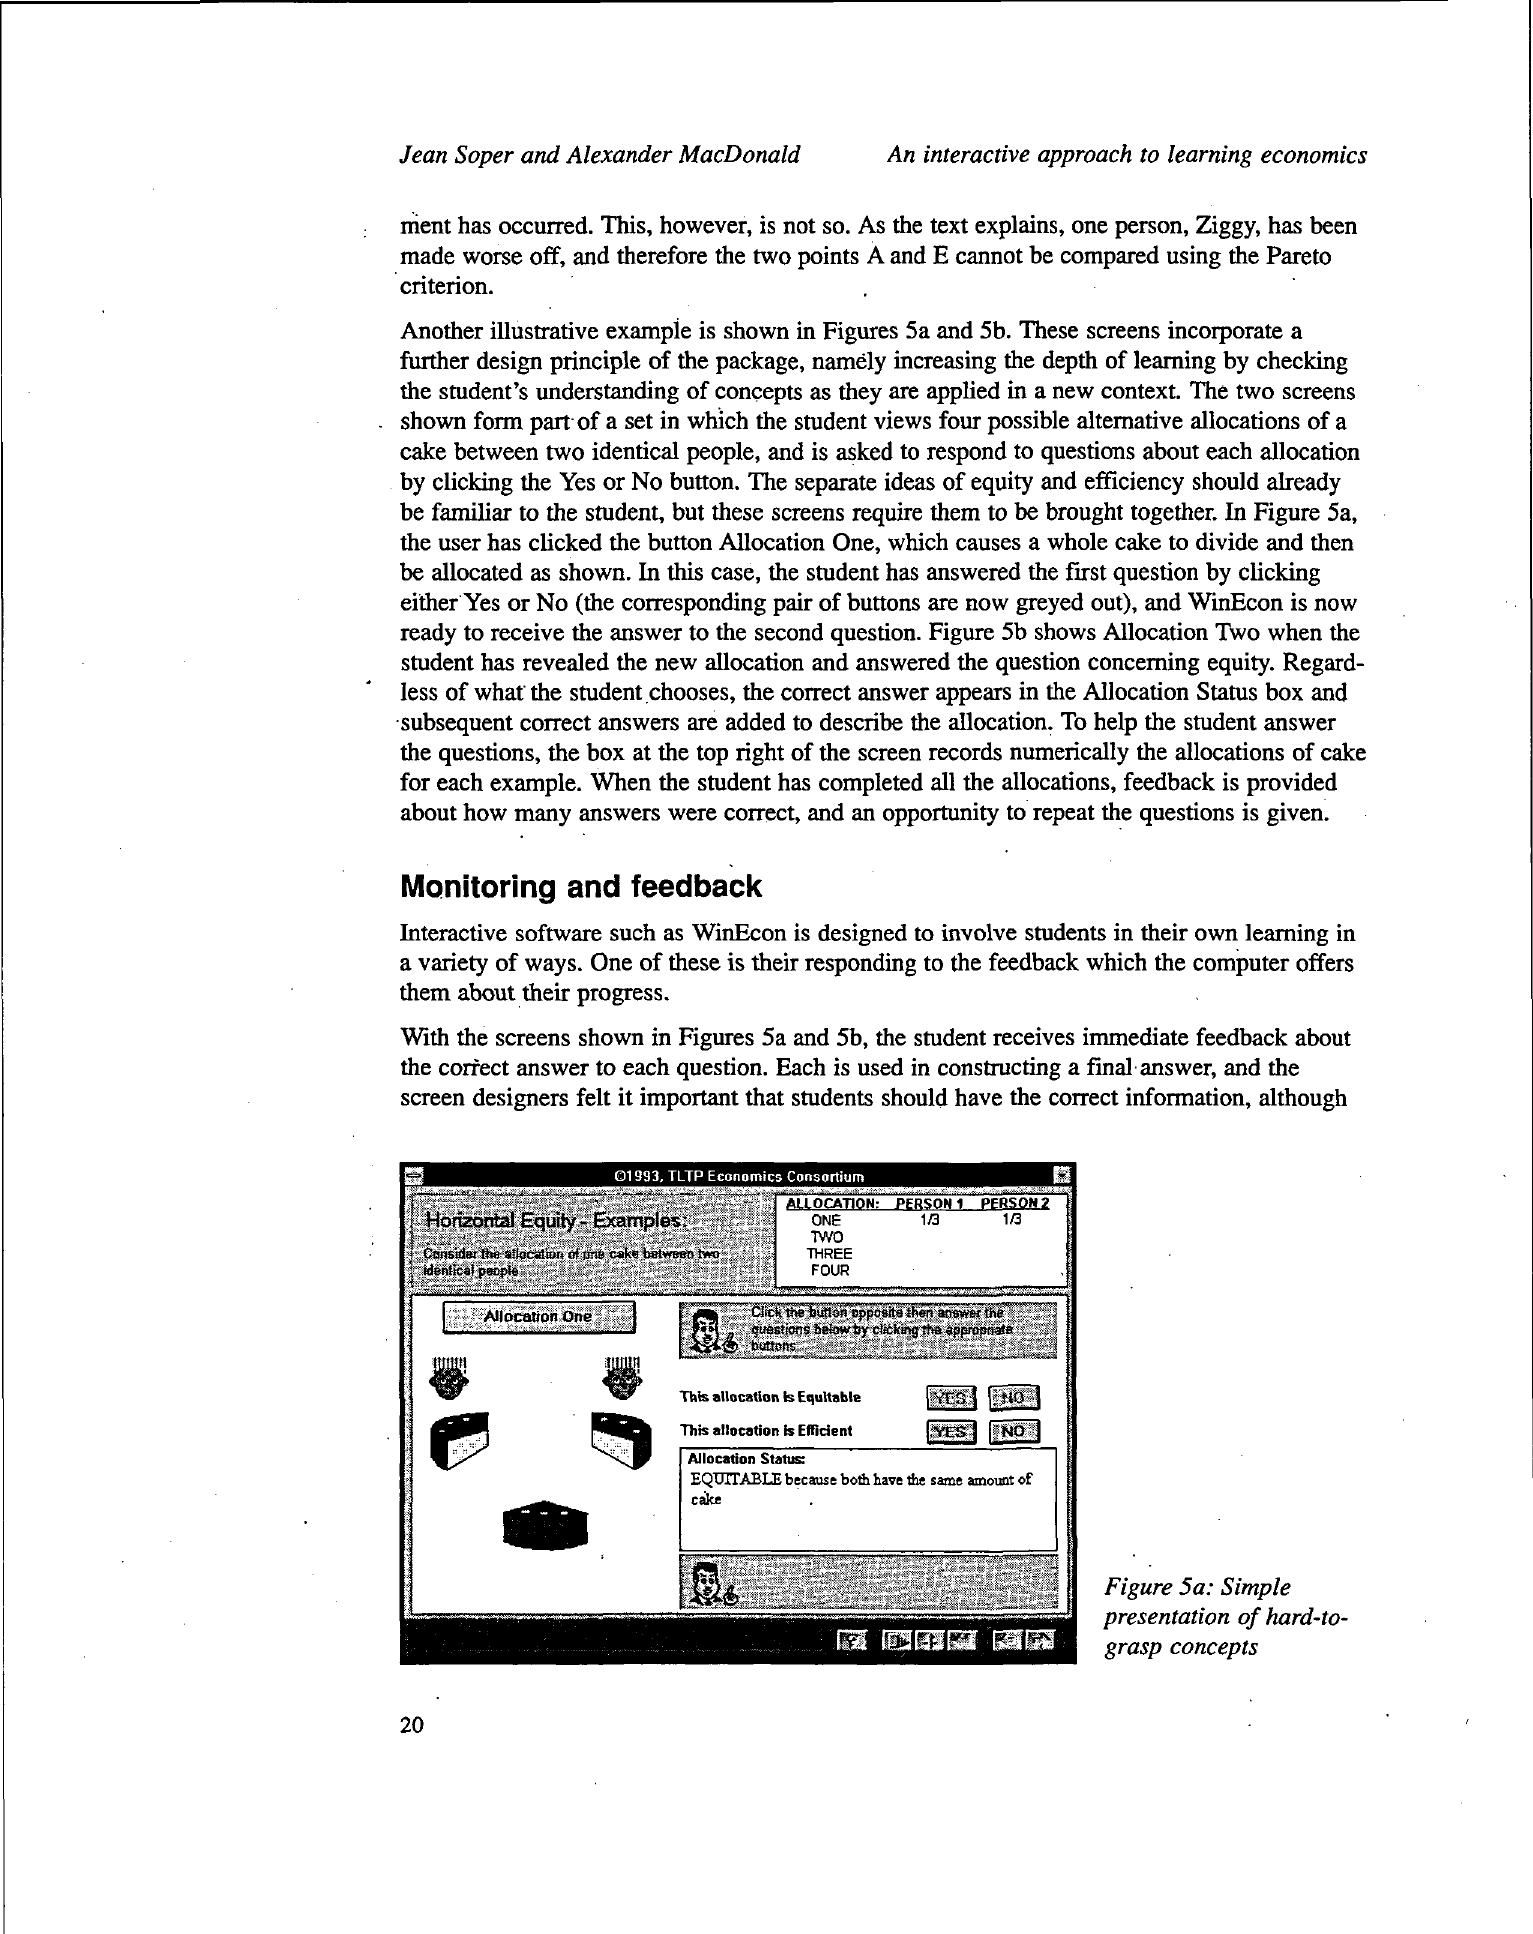
Figure 5a: Simple presentation of hard-to- grasp